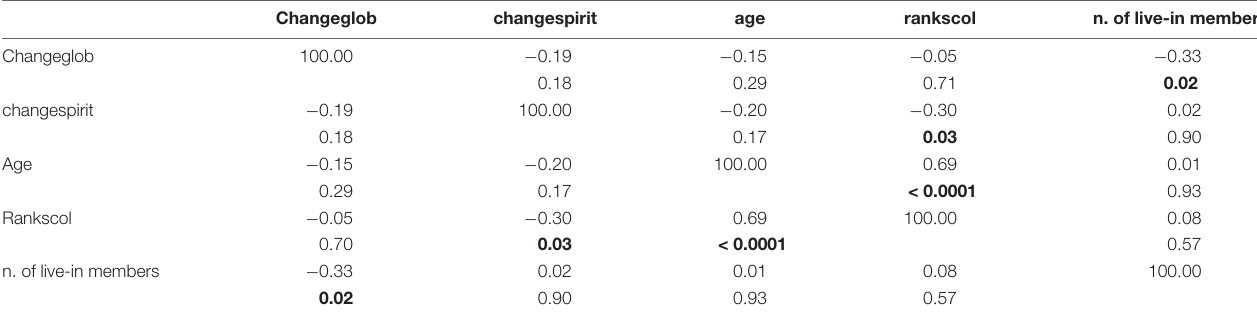
TABLE 6 | Spearman correlation matrix and p values between PTGI components and demographic numerical and ordinal variables. Changeglob